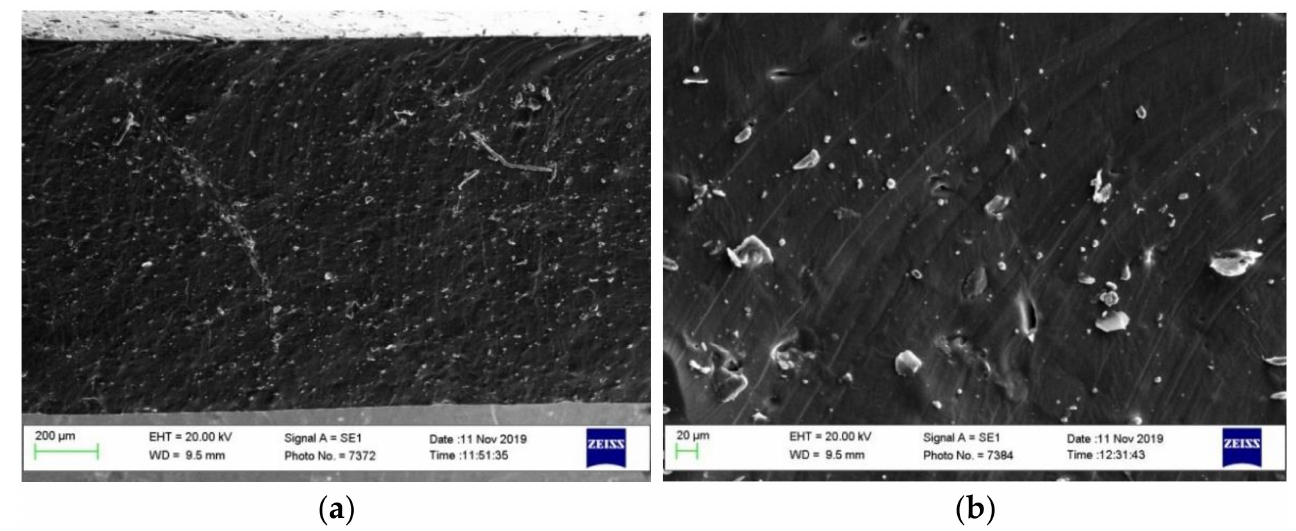
Figure 16. SEM images of the test samples. ( a ) Polymer–Ni; ( b )